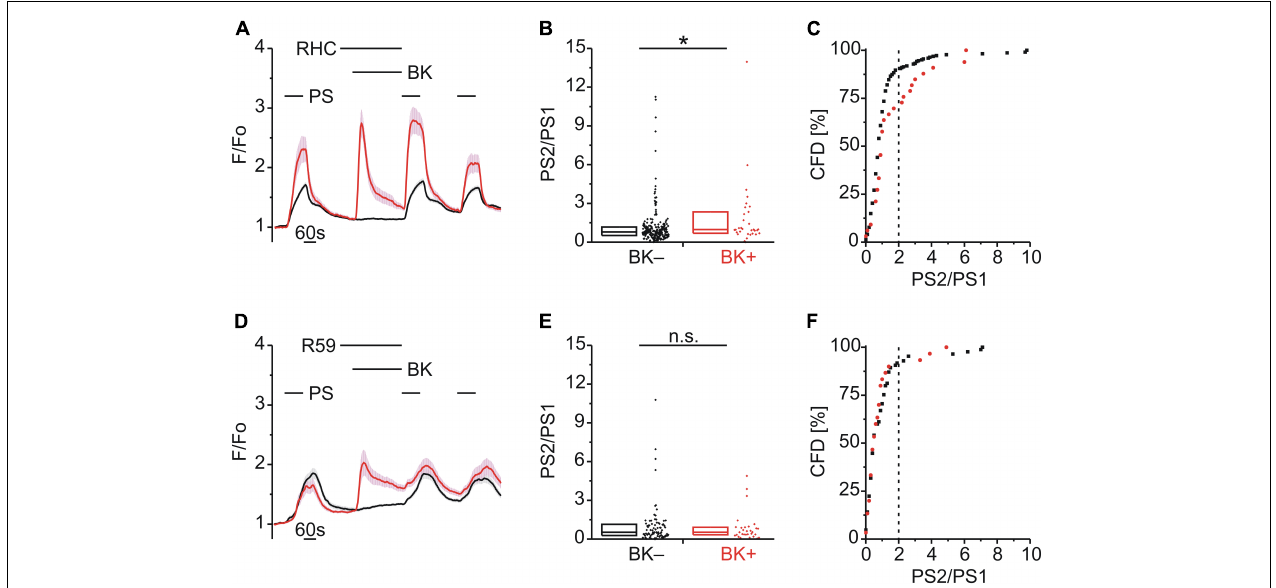
FIGURE 5 | BK-induced TRPM3 sensitization is unaffected by DAG lipase but requires DAG kinase. (A–C) Calcium signals from DRG neurons (A) during repeat application of pregnenolone sulfate (PS; 40 µ M) with bradykinin (BK; 0.5 µ M) applied between PS1 and PS2 and in the presence of the diacylglycerol (DAG) lipase inhibitor RHC-80267 (RHC; 10 µ M). Cells that showed an increase in calcium to BK are indicated in red (BK+ ; A–C ; 33 neurons) and those that did not in black (BK–; A–C ; 222 neurons). PS2/PS1 ratios are shown as a simple distribution ( B , boxes indicate quartiles and centerline median) and cumulative frequency distribution ( C ; CFD). Each dot-like symbol in (B,C) represents the ratio value calculated for a single, individual cell. One BK+ ratio value (“17.9”) in (B) is not displayed for better visibility but was included in the analysis. Values derive from four measurements with cells from one mouse. (D–F) Calcium signals from DRG neurons (D) during repeat application of PS with BK applied between PS1 and PS2 and in the presence of the DAG kinase inhibitor R-59-022 (R59; 10 µ M). BK+ cells are indicated in red ( D–F ; 30 neurons) and BK– cells in black ( D–F ; 85 neurons). PS2/PS1 ratios are shown as a simple distribution (E) and CFD (F) . Values derive from six measurements with cells from two mice. BK+ and BK– groups (B,E) were compared with Mann-Whitney U -tests. * P < 0.05; n.s., not